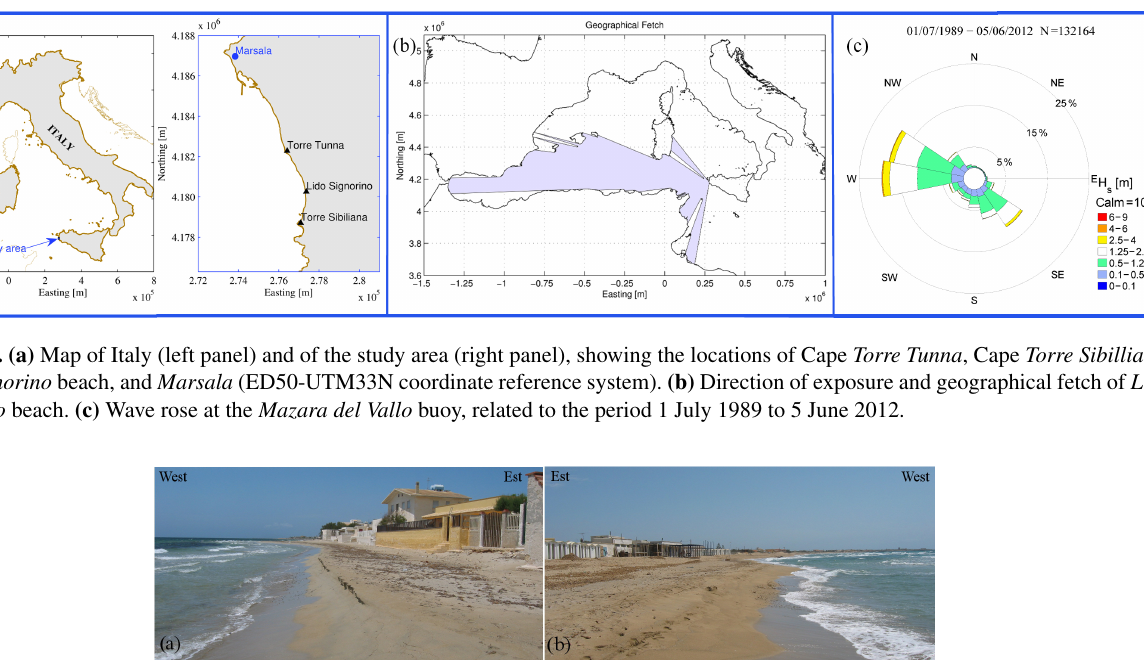
Figure 2. Anthropic pressure in the studied beach: (a) central–northern beach, where buildings are about 4–5m from the shoreline and are reached by waves during sea storms; (b) central–southern beach, where buildings are noticeably farther from the